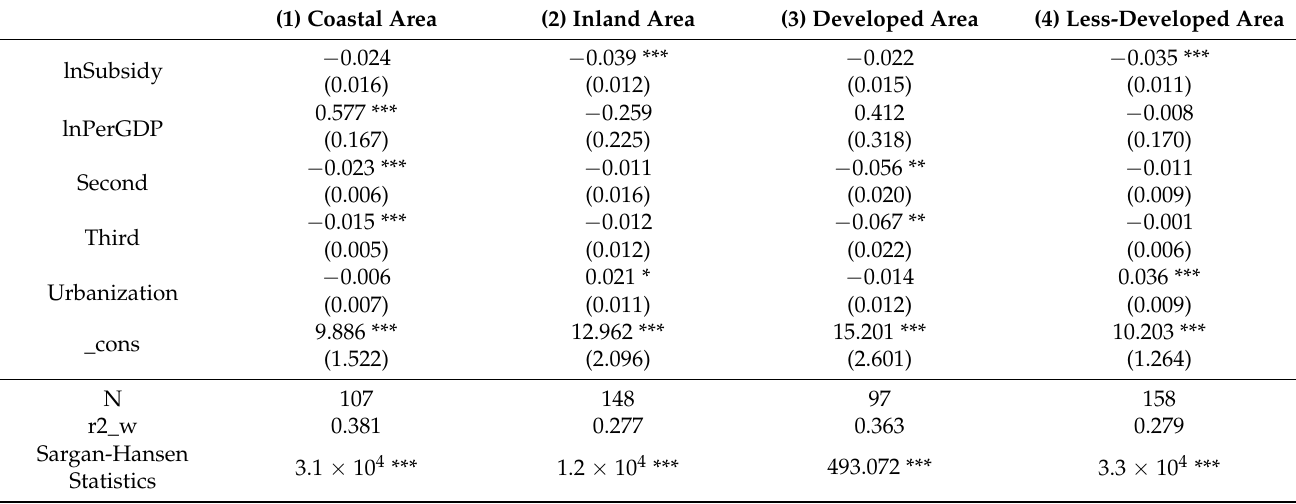
Table 3. Analysis based on the heterogeneity of inland and coastal